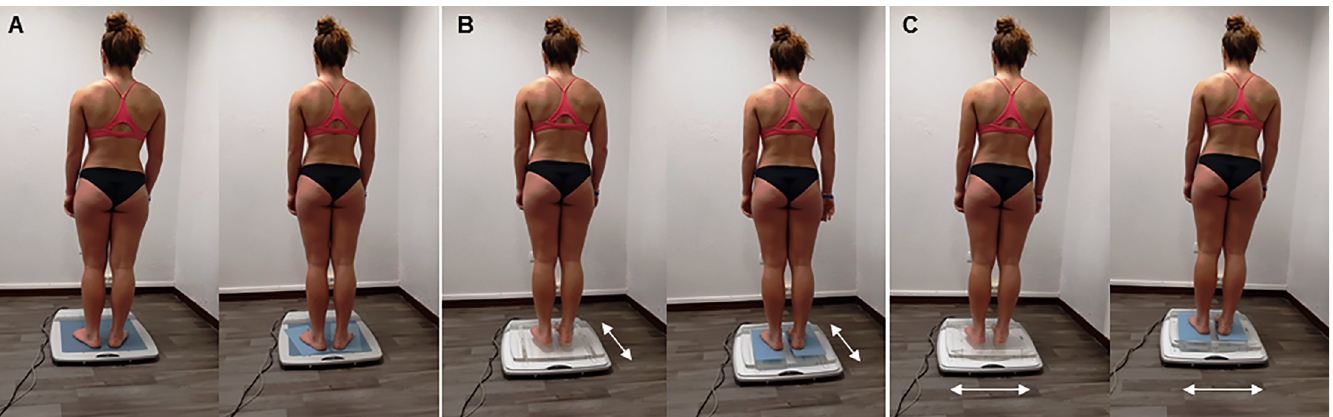
PLOS ONE | https://doi.org/10.1371/journal.pone.0211834 February 5,